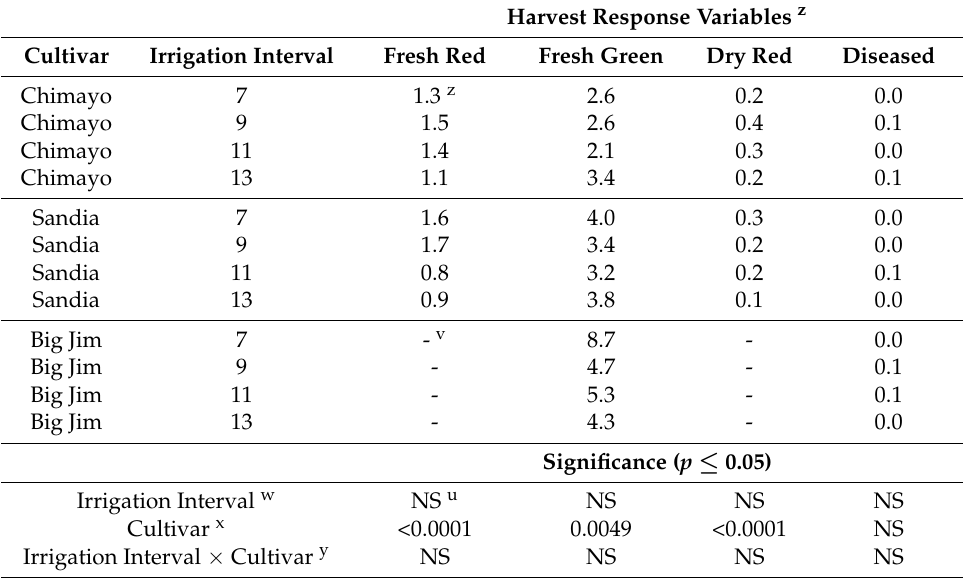
Table 4. Main effects and interactions of three cultivars and four irrigation intervals on yield components,